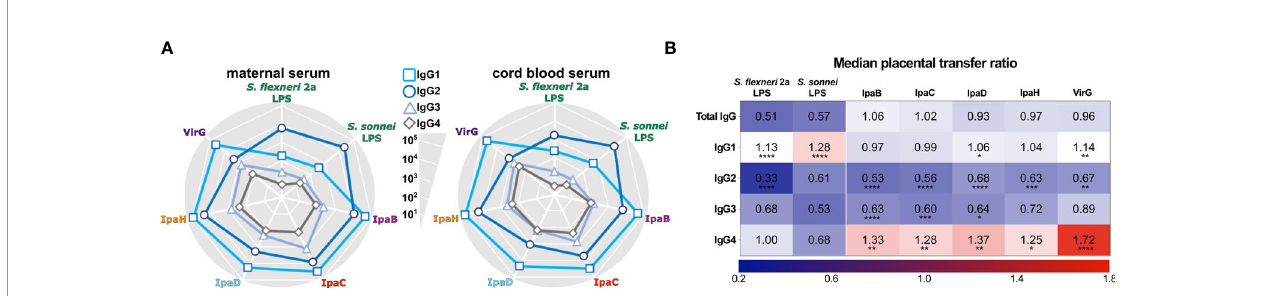
FIGURE 3 | IgG subclass distribution of maternal and infant placentally-acquired antibodies. (A) Radar plots depict IgG1, IgG2, IgG3, and IgG4 levels against Shigella antigens measured in maternal and cord blood sera diluted at 1:100. Symbols represent the geometric mean Electro Chemiluminescence (ECL) Signal. (B) Heatmap representing median placental transfer ratios (cord blood titer/maternal titer) for Shigella antigen-speci fi c IgG and IgG subclasses. Statistically signi fi cant differences between the transfer ratio of each IgG subclass compared to the total IgG transfer ratio were determined by one-way ANOVA with Dunnett ’ s post-test correction following ROUT analysis to exclude outliers; * P < 0.05, ** P < 0.01, *** P < 0.001, **** P